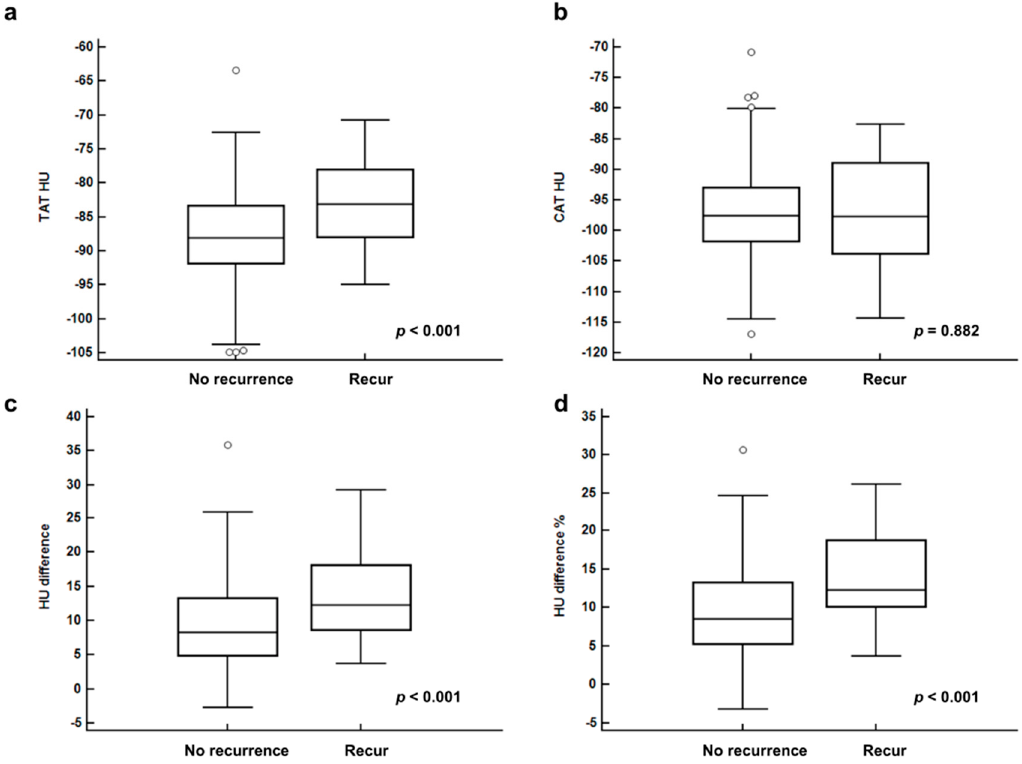
Figure 2. CT-attenuation of tumor-adjacent breast adipose tissue (TAT HU) ( a ), CT-attenuation of contralateral breast adipose tissue (CAT HU) ( b ), difference of CT-attenuation (HU difference) ( c ), and percent difference of CT-attenuation (HU difference %) ( d ) between patients with no recurrence and recurrence.